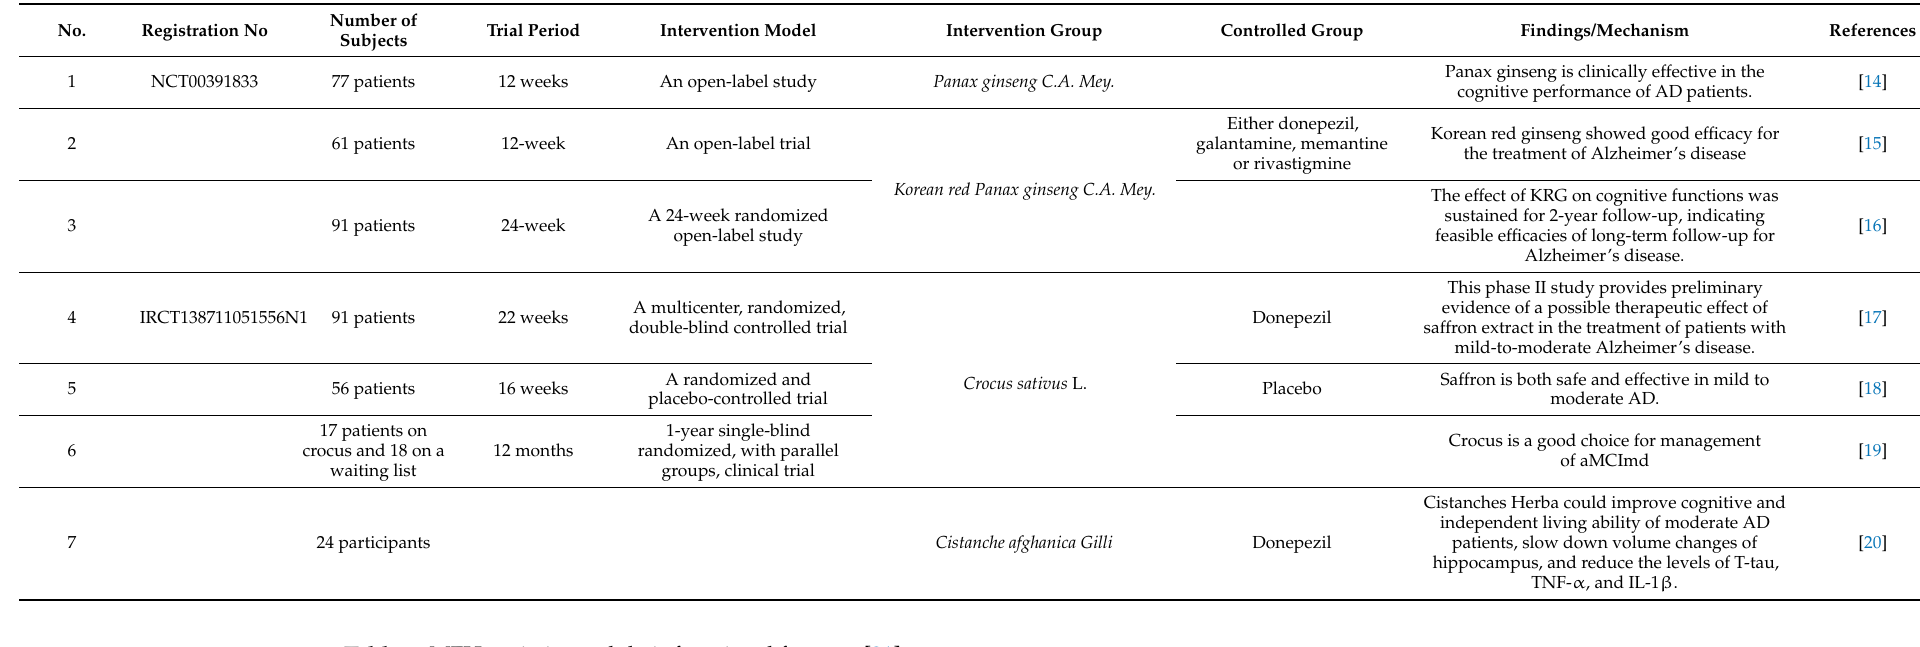
Table 2. MFH varieties and their functional features